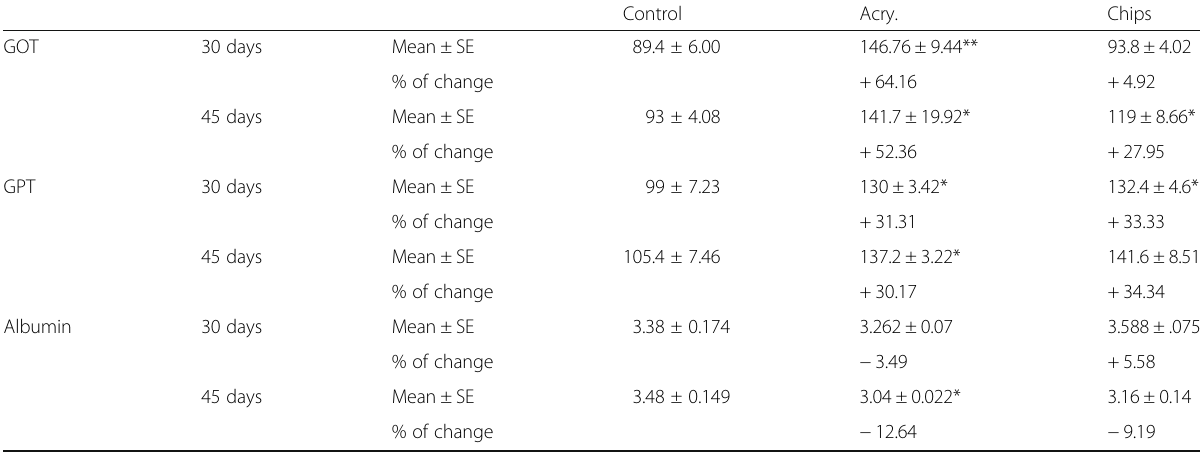
Table 1 Effect of acrylamide and chips administration on the plasma GOT (U/ml), GPT (U/ml), and albumin (g/dl) of mice at 30 and 45 days of administration